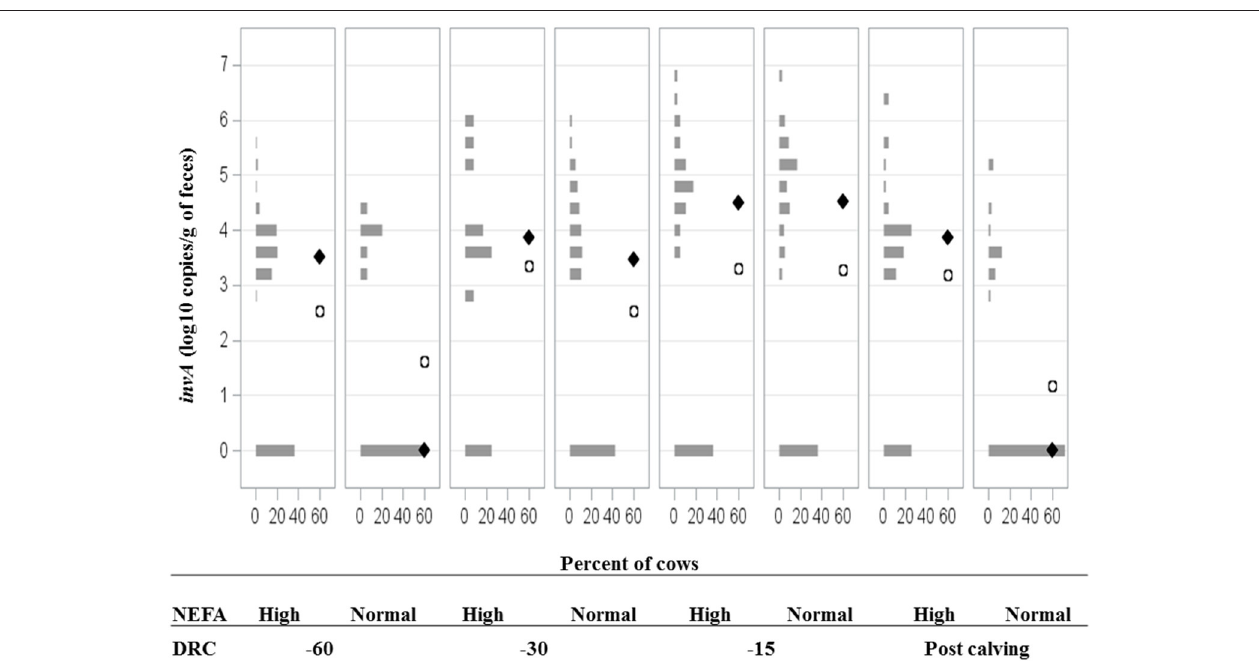
FIGURE 5 | Frequency distribution of Salmonella invA gene fecal concentrations for dairy cattle with high or normal serum concentrations of non-esterified fatty acids (NEFA) at − 60, − 30, − 15 days relative to calving (DRC), and post-calving. Solid diamonds and open circles represent the median and mean, respectively.